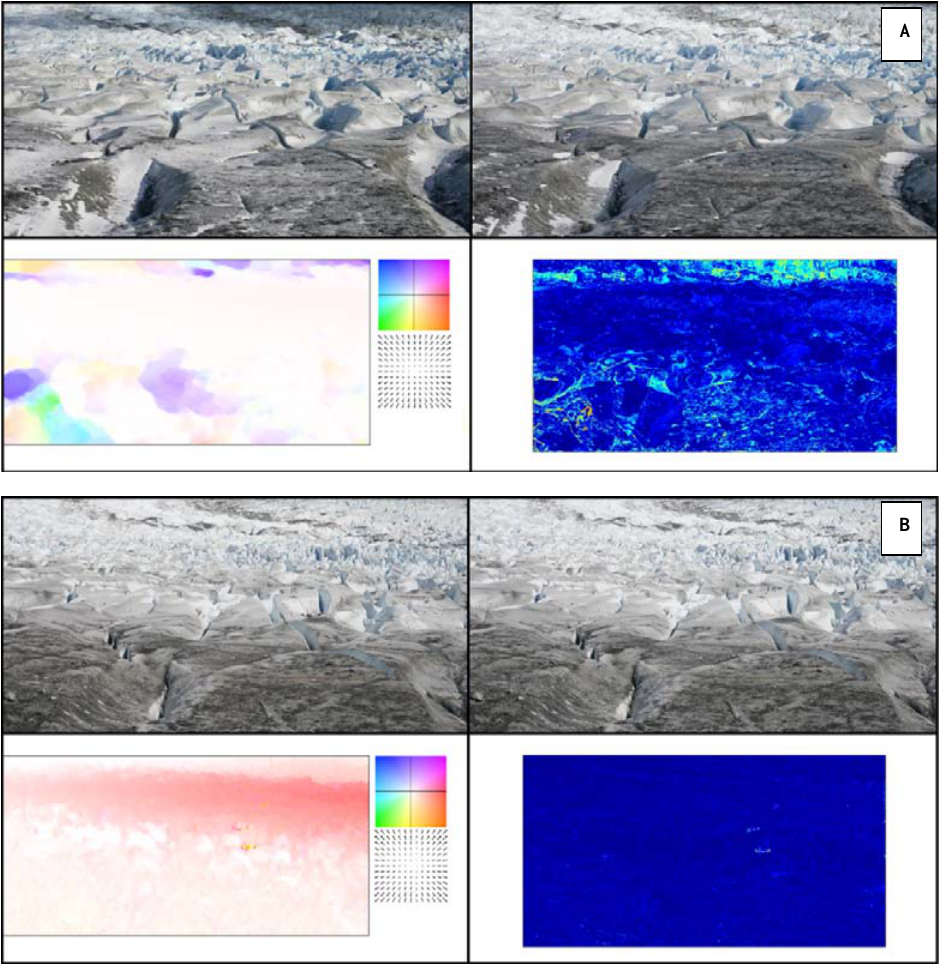
Figure 8. The top frames show the image pair selected to compute the LDOF. Left down shows the flow field estimated with color- coding for a better visualization. Right down show the error reconstruction for the pair. A. An example of changing lighting conditions, and the mismatch of the glacier motion is denoted. B. An example with good lighting conditions, although the glacier has a large displacement is correctly